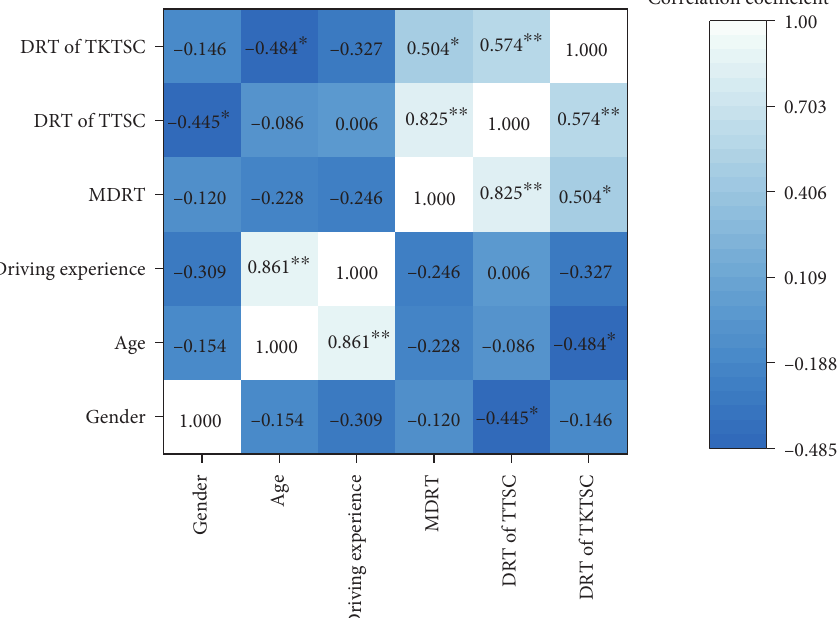
Figure 12: The relevance analysis between other